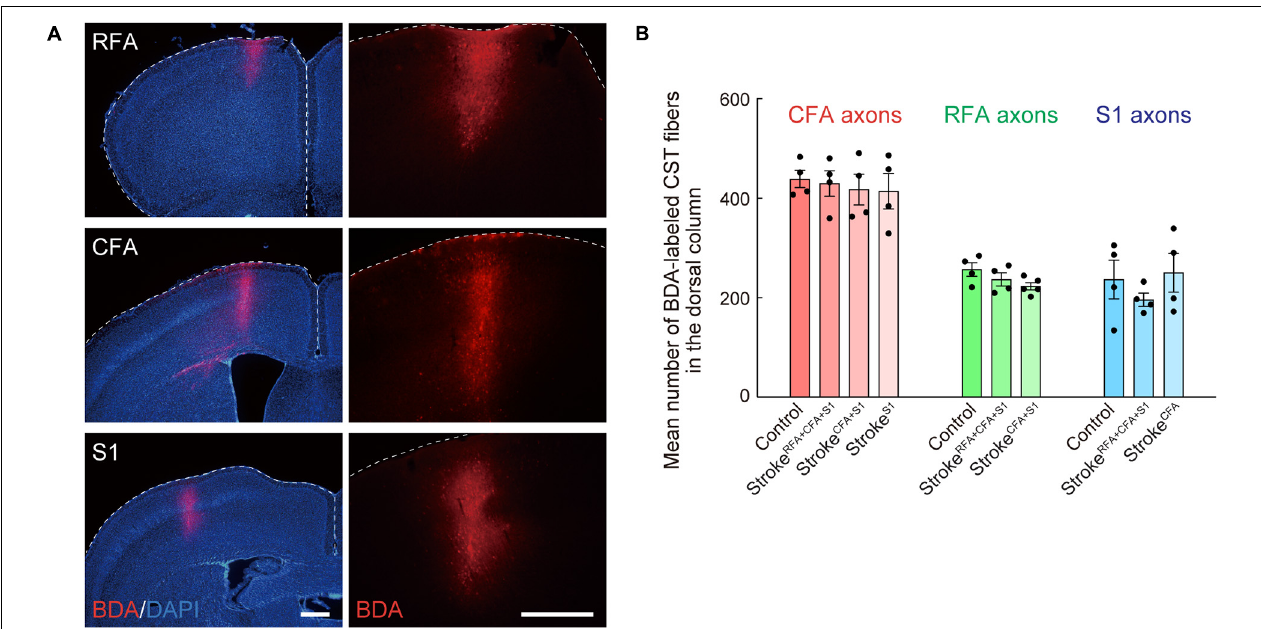
FIGURE 3 | Biotinylated dextran (BDA)-labeling of CST axons of CFA, RFA, and S1. (A) Representative images of the BDA injection site in RFA, CFA, and S1. Right images are magnified views of the left ones. BDA, red; DAPI, blue. Scale bars, 500 µ m. (B) Mean numbers of CST axons of CFA, RFA, and S1 in the dorsal column (C4) of control, stroke RFA + CFA + S 1 , stroke CFA + S 1 , stroke CFA , and stroke S 1 animals, which were used for normalization in Figures 2E,H,K , 4D,K,L , 5E,J